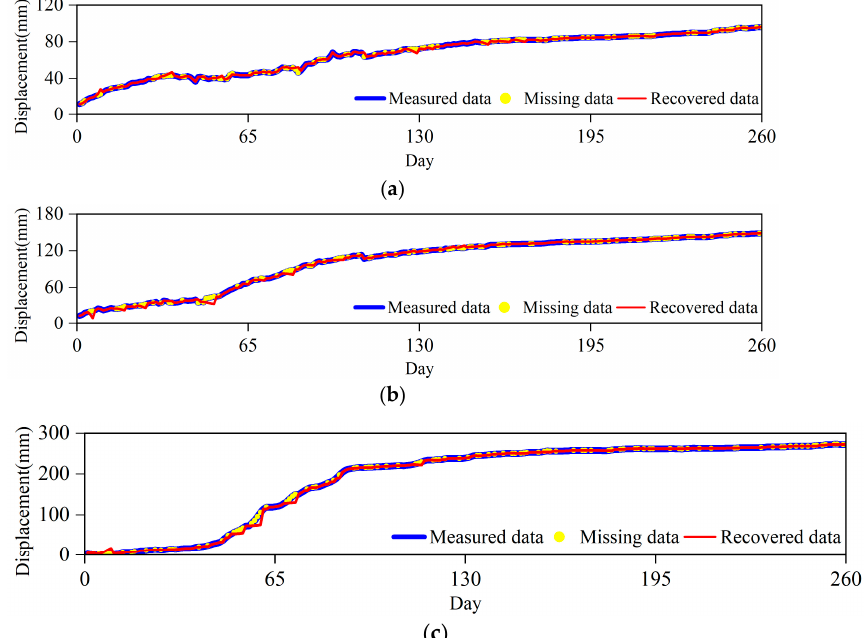
Figure 7. Completion of displacement data (RM40%). ( a ) Point SZY-02; ( b ) point SZY-03; ( c ) point SZY-06. The blue curve represents the measured data, the yellow dots represent the missing data and the red curve represents the recovered data.